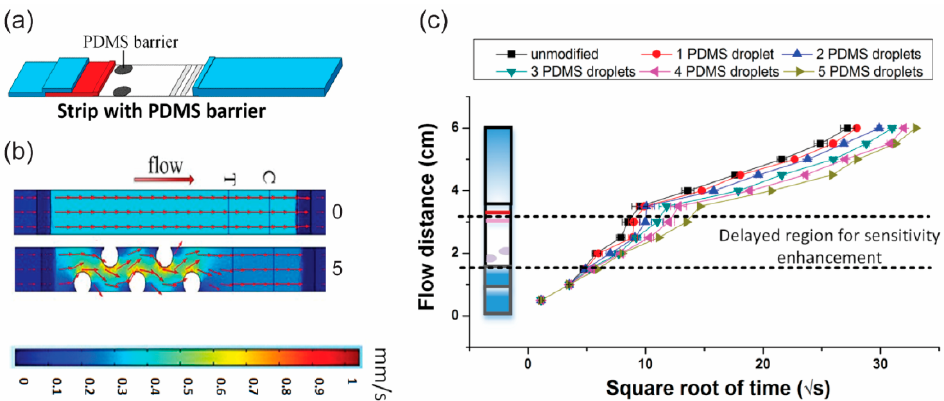
Figure 11. Regulation of the fluid flow in a p-CMF device by using hydrophobic patterns. ( a ) Schematic for the modification of a p-CMF device with PDMS barriers, ( b ) simulation of the flow of fluid in an unmodified and a modified channel, and ( c ) flow distance versus square root of time in the p-CMF devices unmodified and modified with different numbers of PDMS droplets (barrier). Adapted with permission from the authors of [86]. Copyright 2016 American Chemical Society.